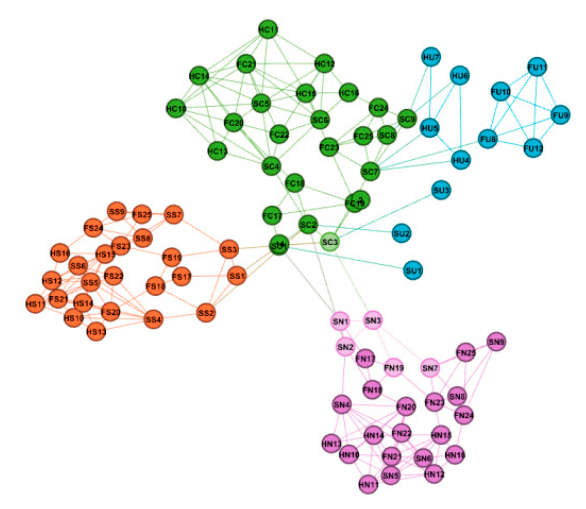
Figure 3. Space topology diagram of the space-based information network.